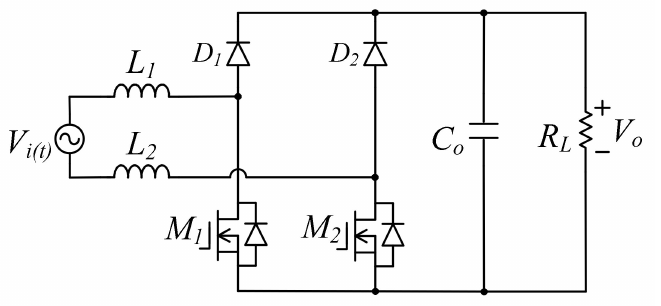
Figure 2. Schematic diagram of the bridgeless boost converter without low common-mode (CM) noise for PFC applications.